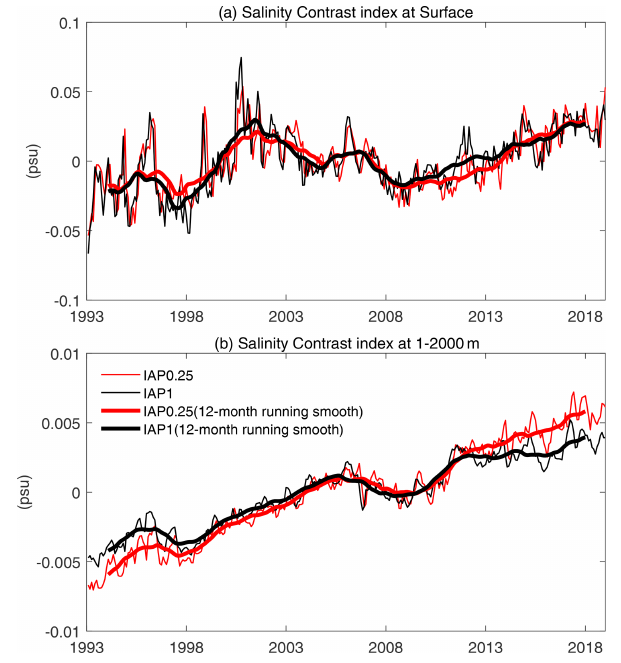
Figure 13. Salinity contrast time series for IAP1 ◦ and IAP0.25 ◦ data in global regions from 1993 to 2018: (a) at the surface and (b) in the upper